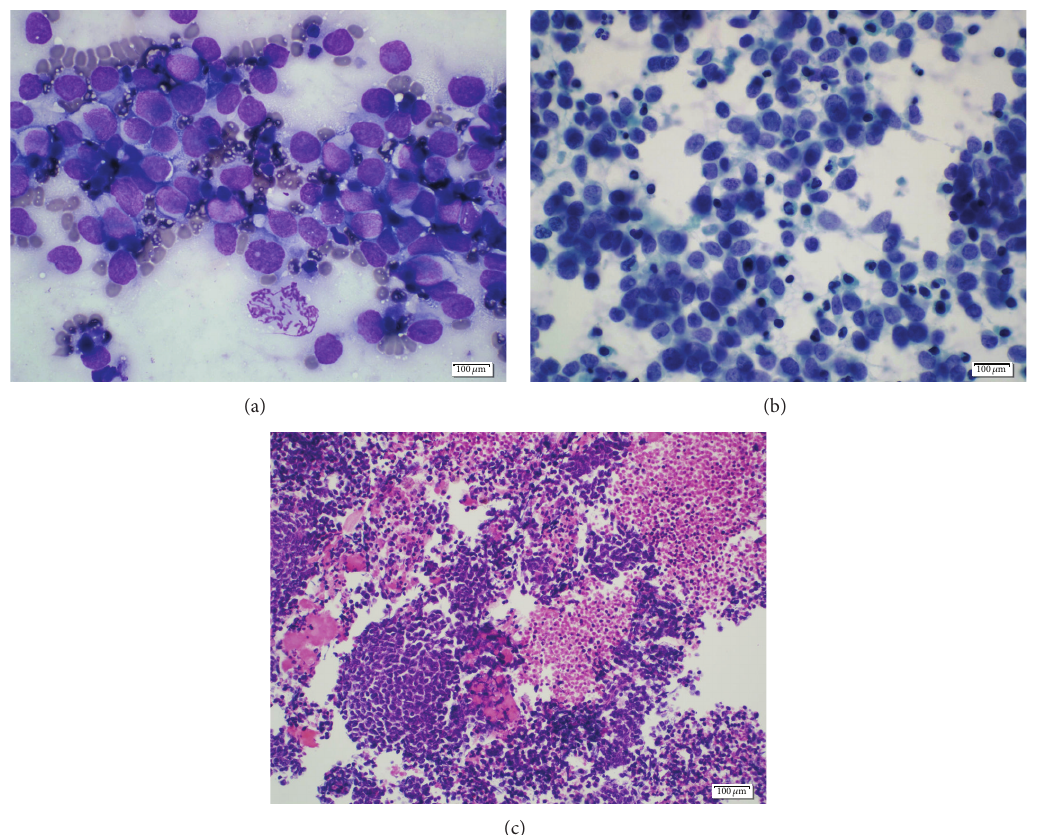
Figure 5: (a) A Diff-Quick stained, air-dried direct smear of Ewing’s sarcoma shows a monotonous population of tumor cells with high nuclear: cytoplasmic ratio. Scattered apoptotic cells in the background give an appearance of “double population.” (b) Pap-stained, Alcohol fixed direct smear of Ewing’s/PNET shows a malignant small round cell tumor, singly and in loosely cohesive clusters. Numerous apoptotic cells are present. The tumor cells demonstrate mild to moderate nuclear pleomorphism, irregular nuclear contour with fine chromatin, and inconspicuous nucleoli. (c) Pap-stained, alcohol fixed direct smear of Ewing’s/PNET shows a malignant small round cell tumor, singly and in loosly cohesive clusters. Numerous apoptotic cells are present. The tumor cells demonstrate mild to moderate nuclear pleomorphism, irregular nuclear contour with fine chromatin, and inconspicuous